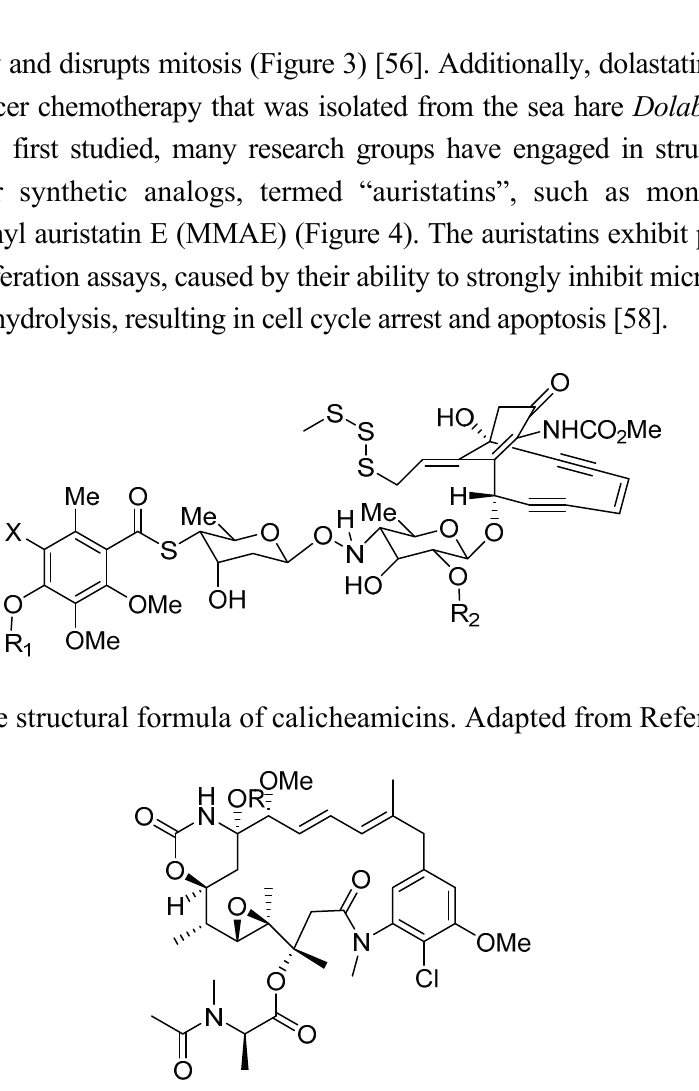
Figure 3. The structural formula of maytansines. Adapted from Reference [56].